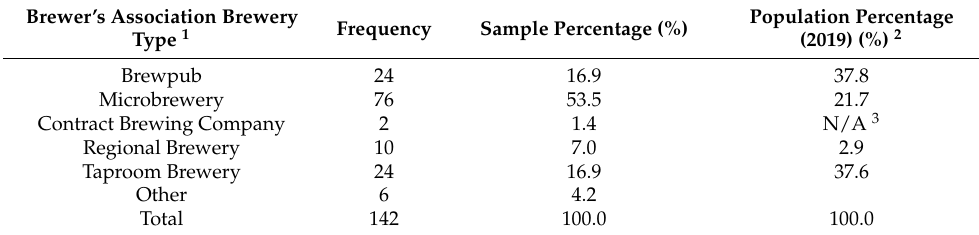
Table 1. Brewery Sample Characteristics: Brewery Type.